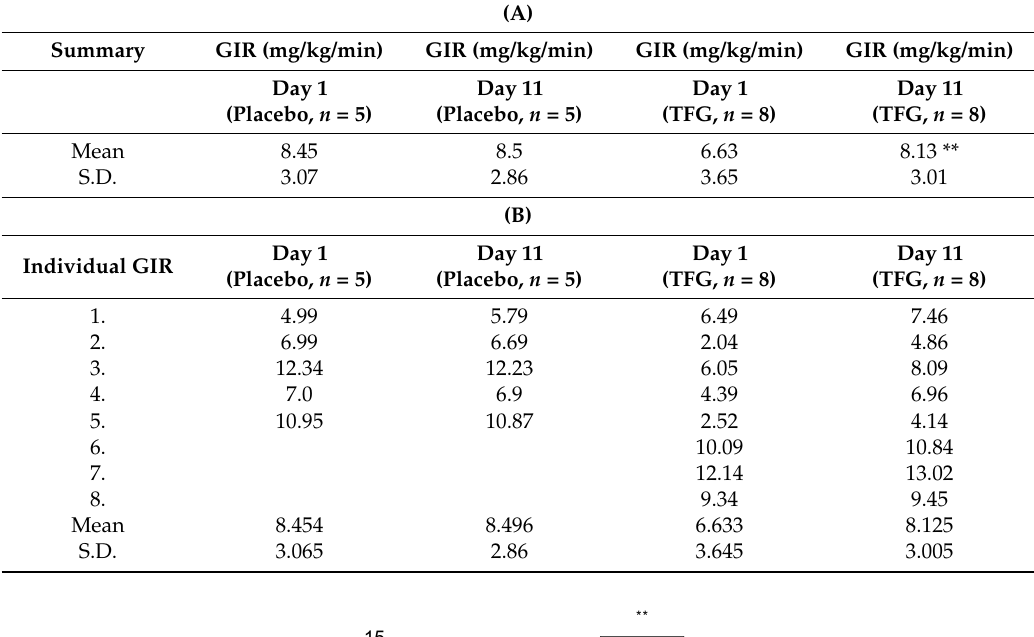
Table 1. ( A ) Influence of TFG ( Trigonella foenum graecum ) on GIR (Glucose Infusion Rate) in the placebo- and fenugreek-treated subjects. ** represents statistically significant difference ( p < 0.01) compared to the Day 1 TFG group; ( B ) Individual GIR values of volunteers in Placebo and TFG-treated group. GIR is expressed as mg/kg/min.